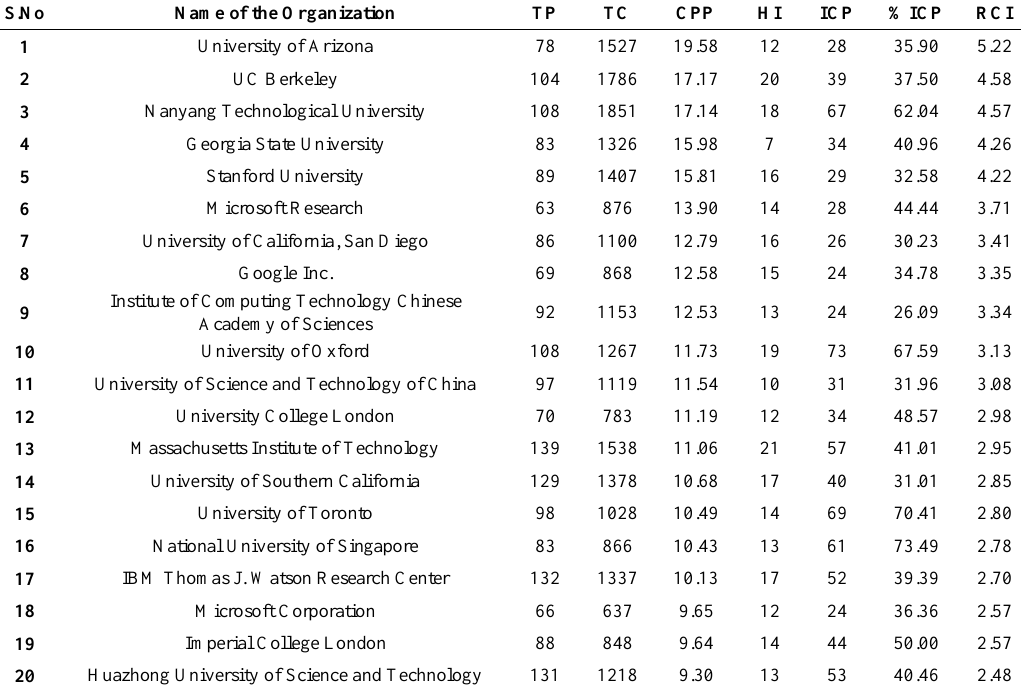
Table 7. Relative Citation Index: of Top 20 Organizations in Big Data Research by 2007-16. S.No